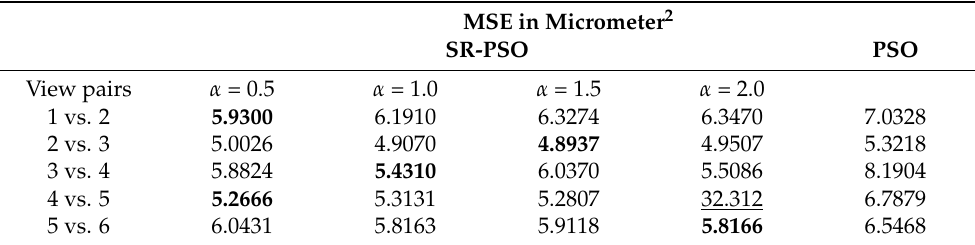
Table 5. MSE from SRPSO and PSO for the regular-tooth model (the best value is in bold and the worst value is